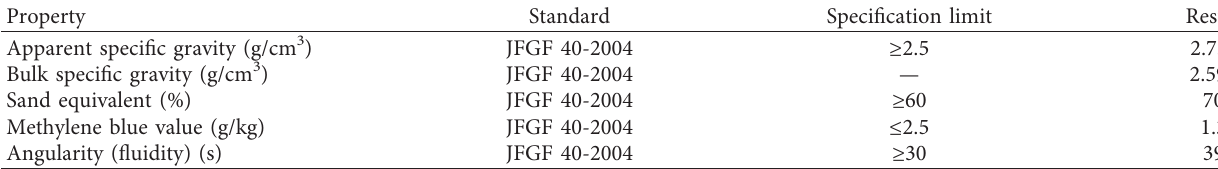
Table 3: Physical properties of the fine aggregate.